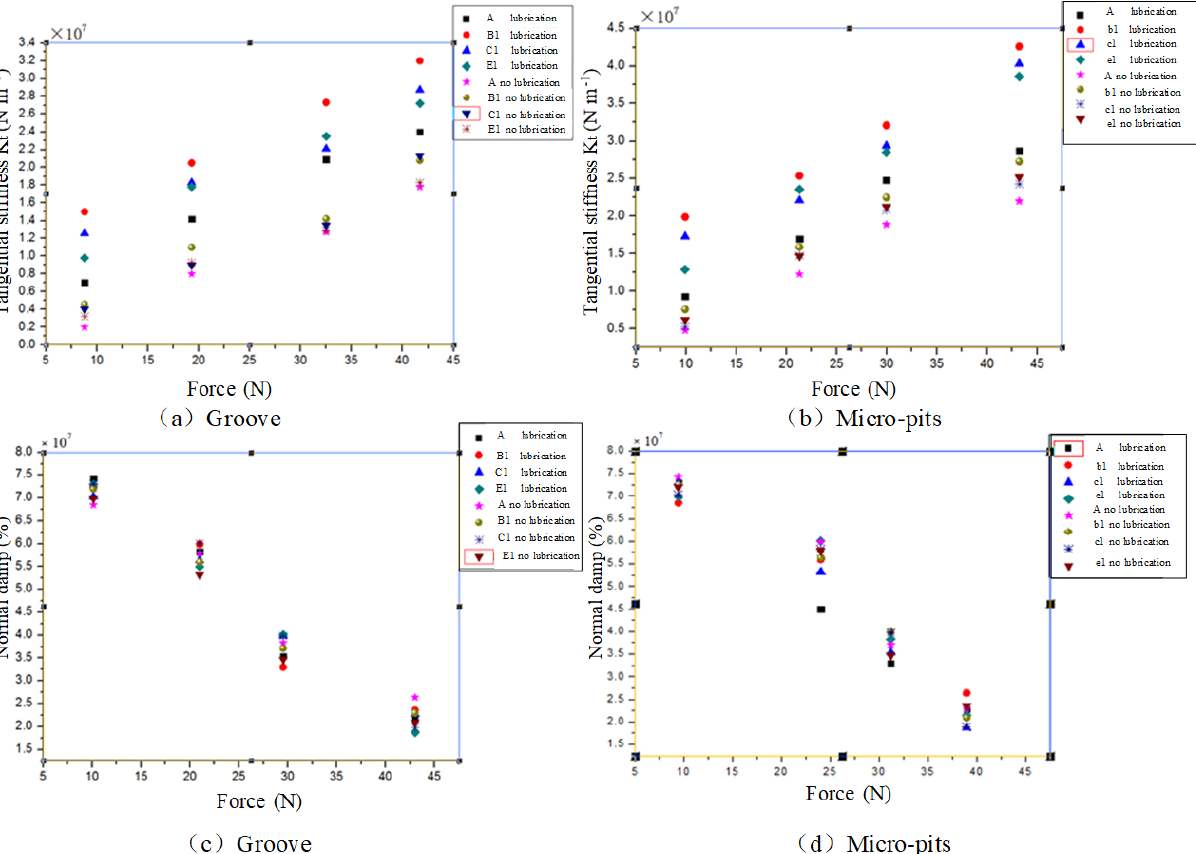
Figure 19. (a, b) The impact of lubrication on the normal stiffness (groove and micro-pits). (c, d) The impact of lubrication on the normal damp (groove and